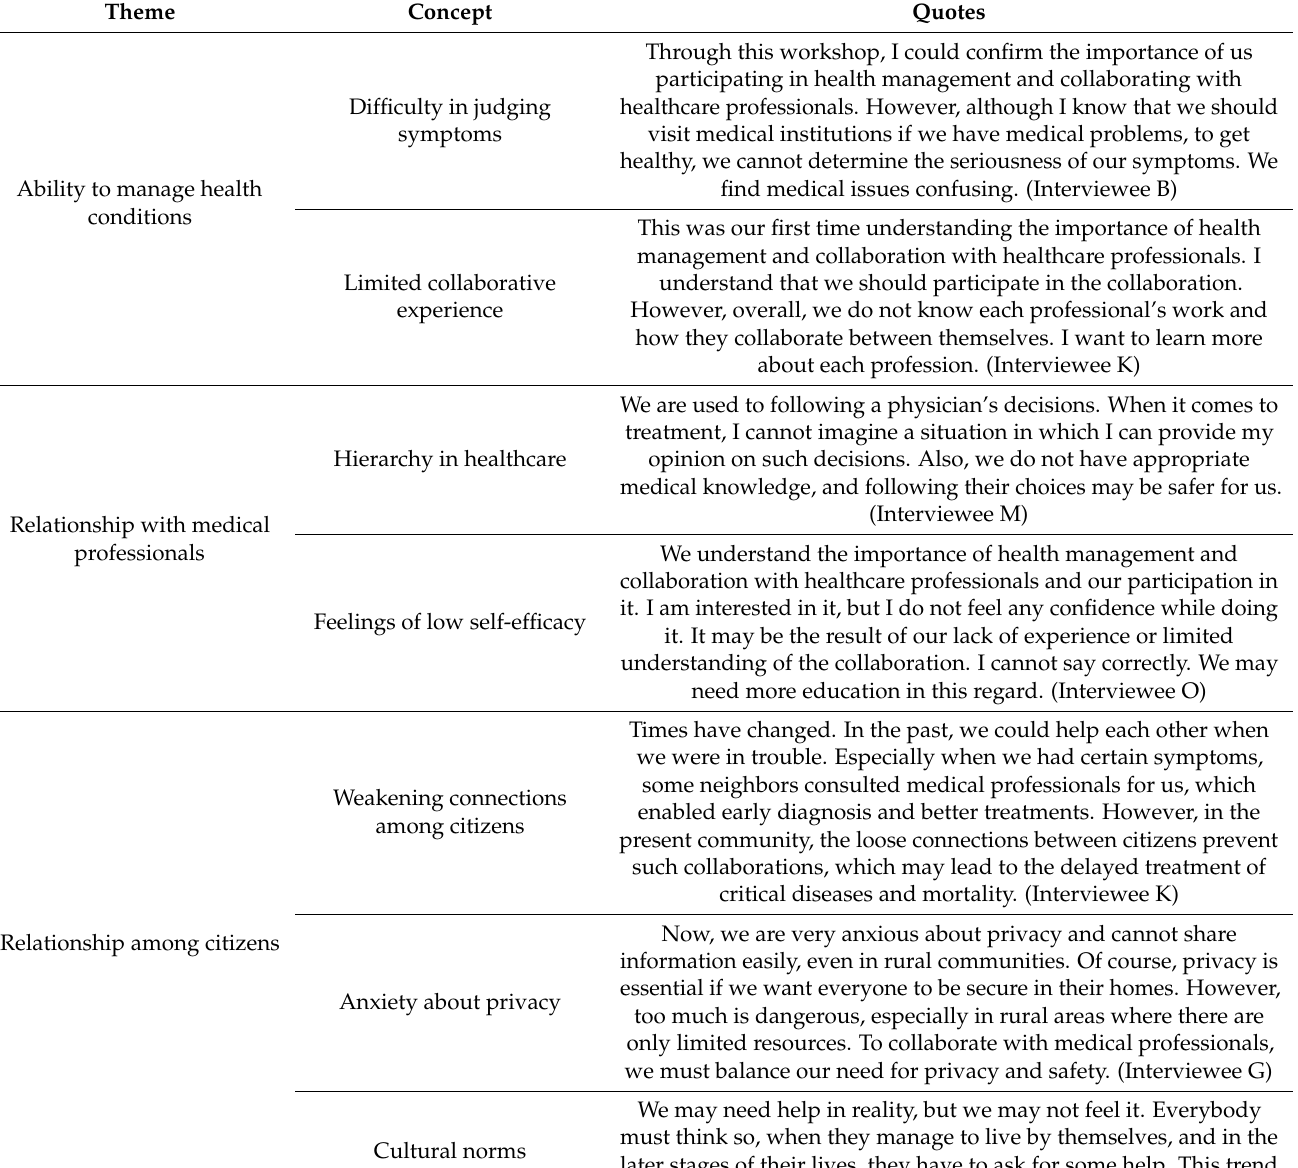
Table 4. Themes and concepts developed through direct content